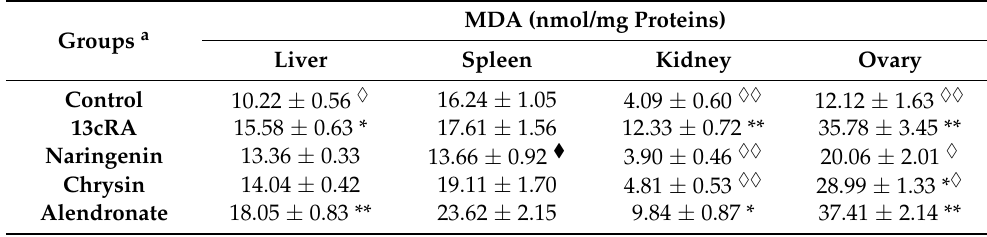
Table 4. Effects of naringenin, chrysin, or alendronate on oxidative stress markers in liver, kidney, spleen, and ovary tissues in rats with retinoic-acid-induced osteoporosis. Groups